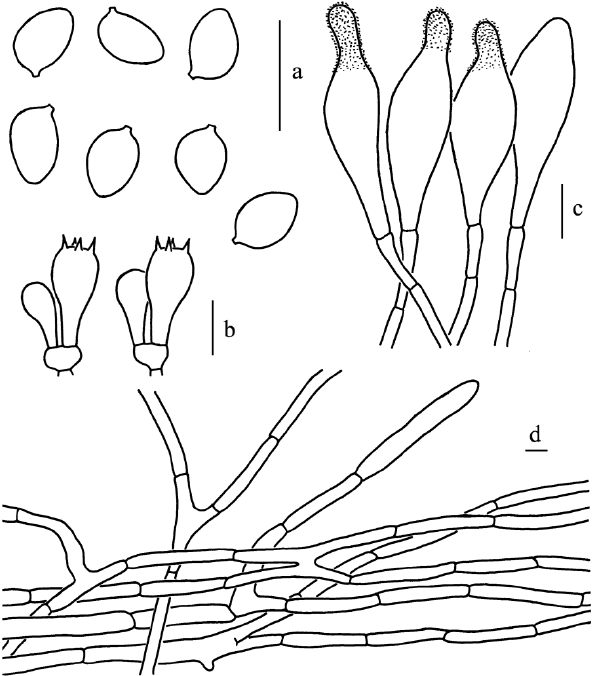
Figure 7. Leucoagaricus aurantioruber (CFSZ 19756). ( a ) Basidiospores. ( b ) Basidia. ( c ) Cheilocystidia. ( d ) Elements of pileus squamules. Scale bars: 10 μm. to orange–reddish, radially arranged fibrillose squamules; ellipsoid to ovoid basidio- spores; subfusiform cheilocystidia with tiny crystals; and squamules composed of branched, thin-walled hyphae.